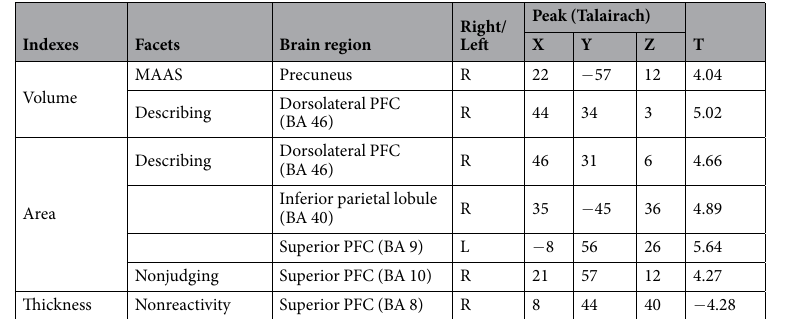
Table 2. Brain coordinates corresponding to cortical volume, volume and surface area in Figs 2 and 3.